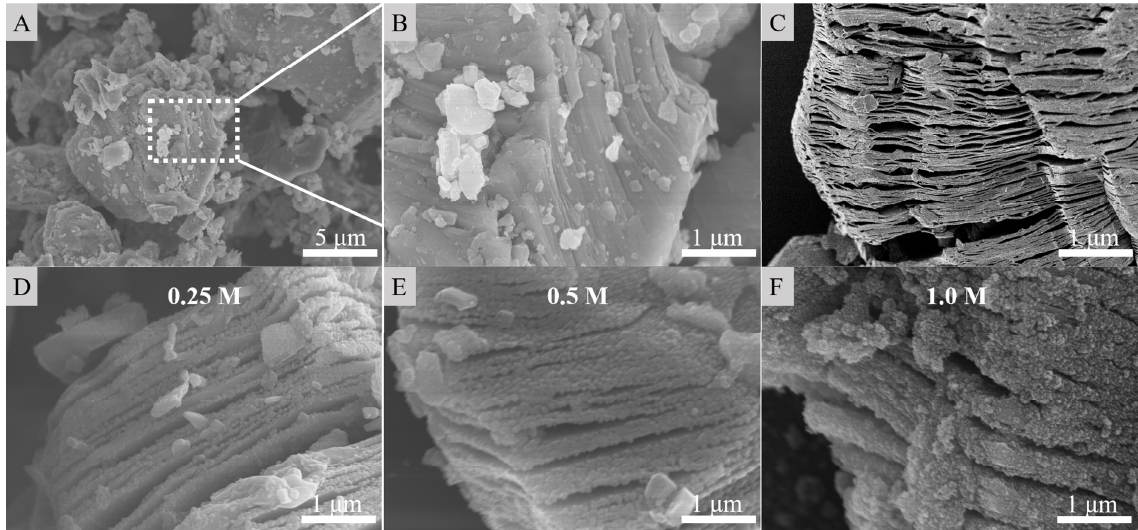
Figure 1. SEM images of Ti 3 AlC 2 ( A , B ), Ti 3 C 2 ( C ) and TiO 2 /Ti 3 C 2 synthesized by different concentration of TiO 2 precursor solution (( D ) 0.25 mol; ( E ) 0.5 mol; ( F ) 1.0 mol).